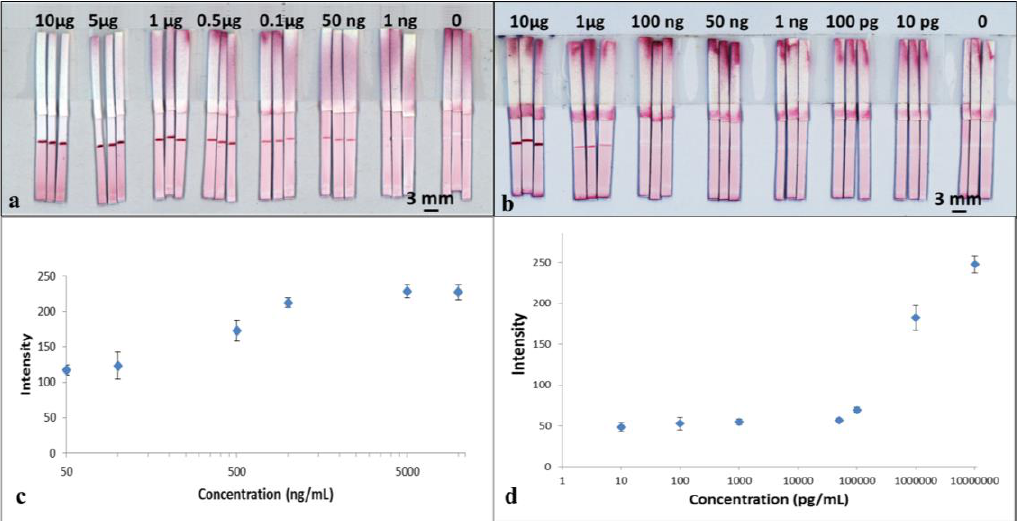
Figure 4. Scanned images of sets of the standard single ( a ) CRP and ( b ) SAA1 LFDs with various CRP and SAA1 analyte concentrations, in each case per ml. ( c , d ) show calibration curve constructed using the grayscale intensity values taken from the image shown in ( a , b ). Error bars indicate the standard deviation for 3 individual measurements.